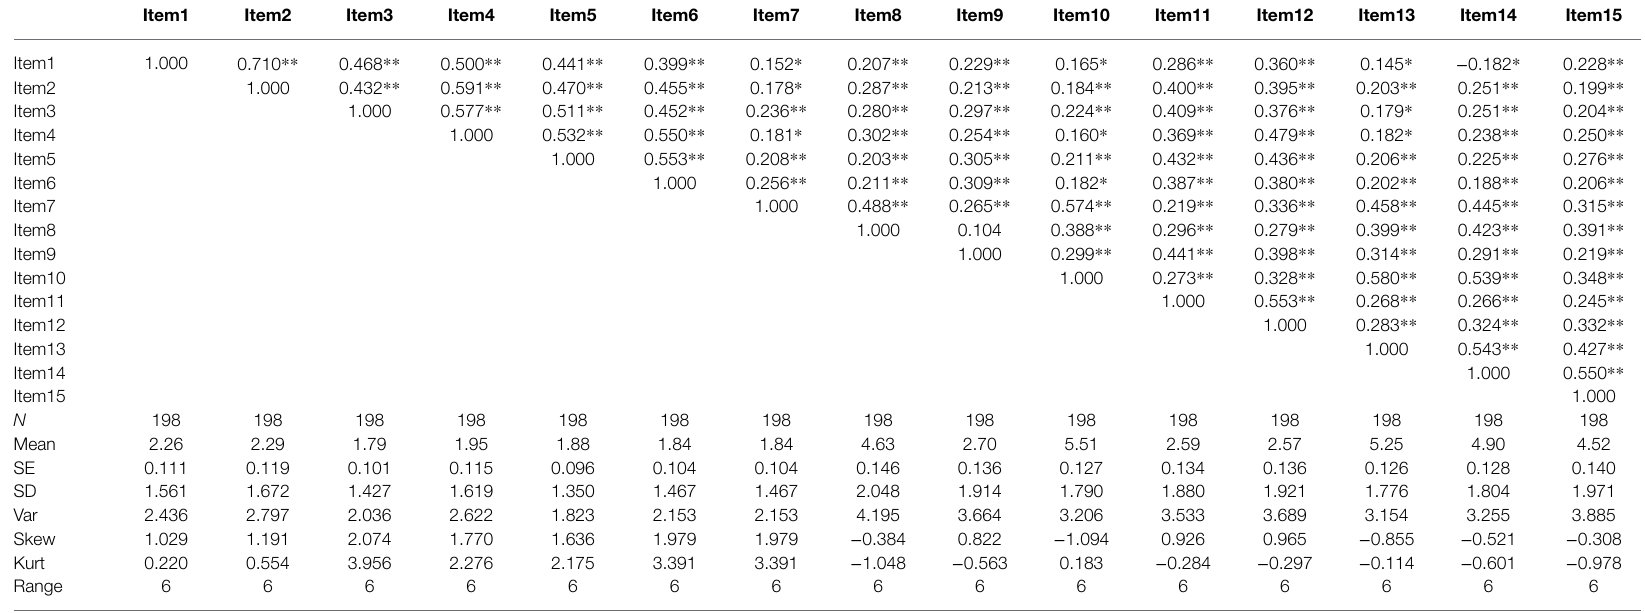
TABLE 1 | Descriptive statistics and inter-correlations of the interpersonal needs questionnaire items. Item1